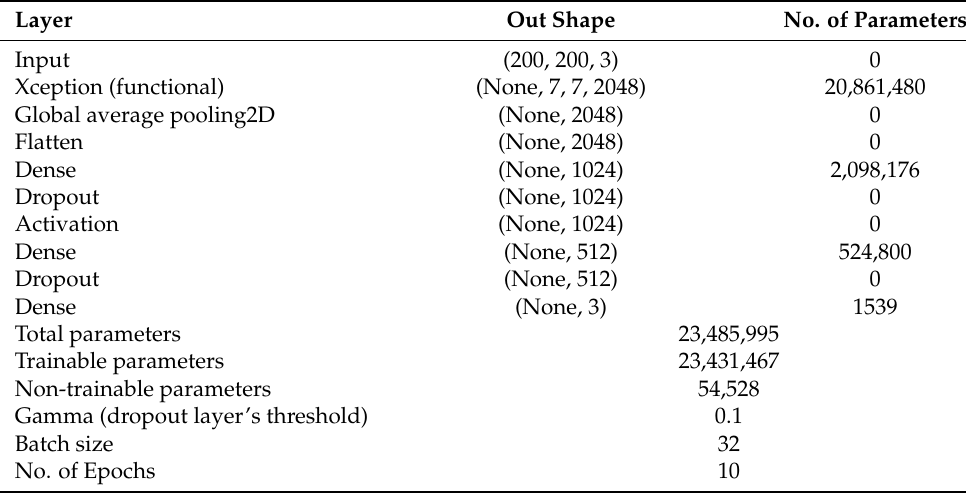
Table 1. Summary of the parameter settings of the proposed structure. Layer Out Shape No. of